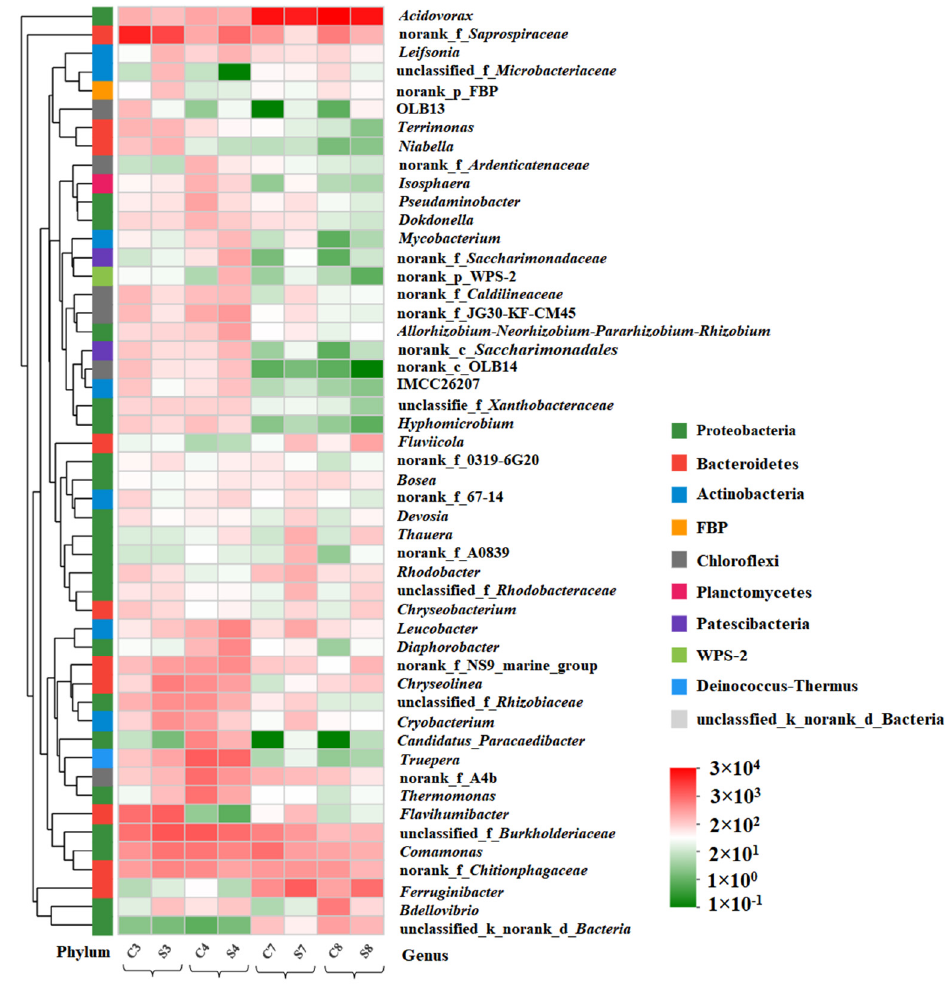
Figure 5. Microbial community structures of the eight samples at the genus level.